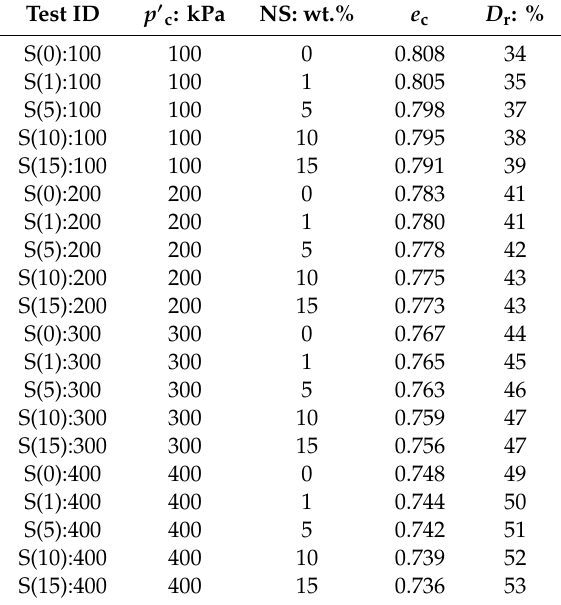
Table 4. Basic properties of test